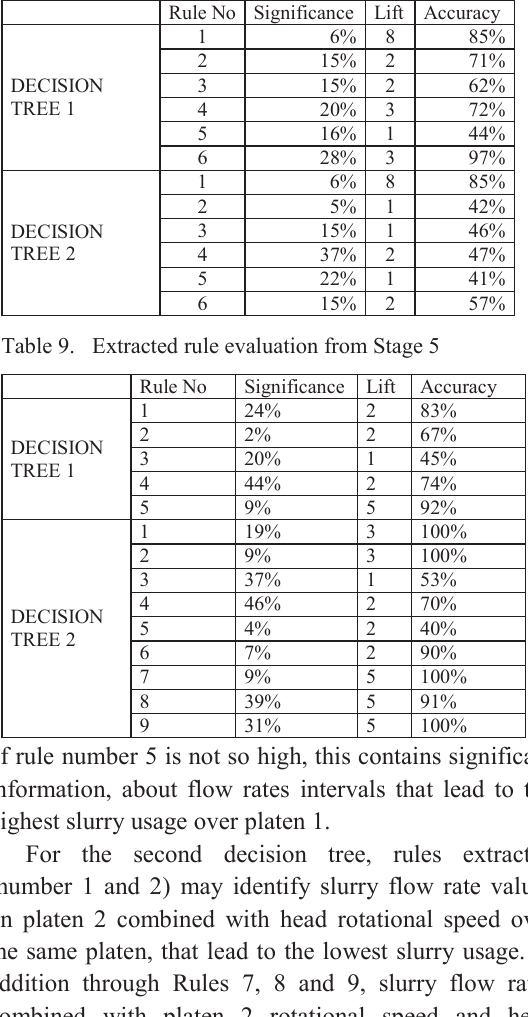
Table 8. Extracted rule evaluation from Stage 3